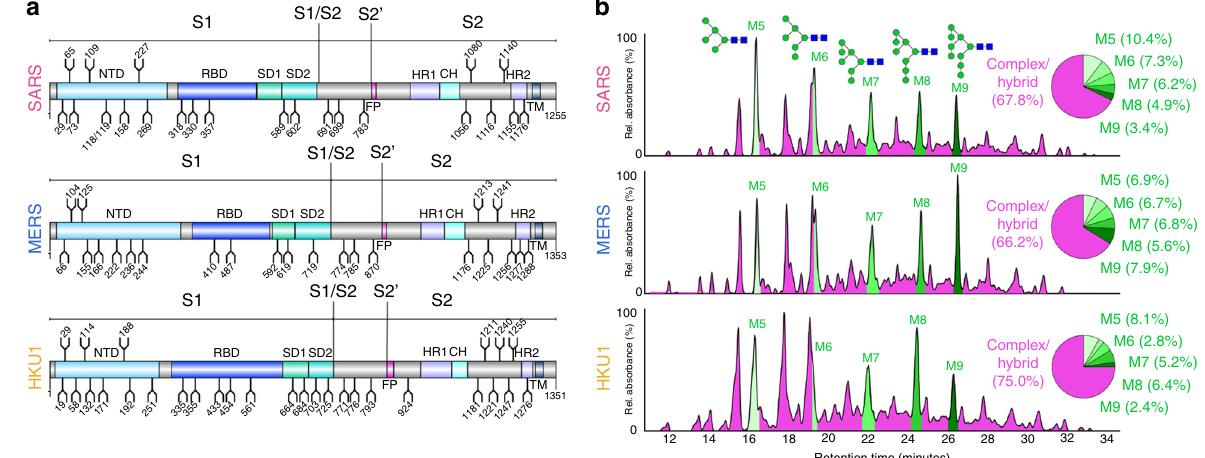
Fig. 1 Compositional analysis of SARS, MERS and HKU1 glycans. a Schematic representation of SARS, MERS and HKU1 coronavirus S glycoproteins, showing the positions of N-linked glycosylation amino-acid sequons (NXS/T, where X ≠ P) shown as branches. The domains of the S glycoproteins are illustrated: N-terminal domain (NTD), receptor-binding domain (RBD), sub-domain 1/2 (SD1/2), fusion peptide (FP), heptad repeat 1/2 (HR1/2), central helix (CH), and transmembrane domain (TM). b HILIC-UPLC chromatograms of fl uorescently labelled N-linked glycans from SARS, MERS and HKU1 S. Oligomannose-type glycans (M5 to M9; Man 5 GlcNAc 2 – Man 9 GlcNAc 2 ) (green) and complex-type glycans (magenta) were identi fi ed by Endo H digestion, with quanti fi cation of major glycan types summarised as a pie chart. Oligomannose-type glycans are schematically annotated with mannose residues as green circles and GlcNAc residues as blue